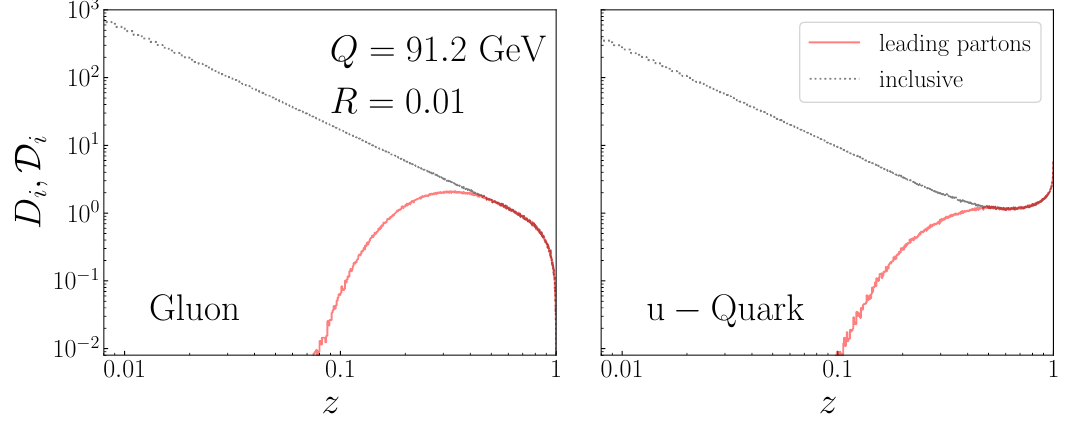
Figure 20 . Fragmentation spectrum of inclusive and leading partons for gluons (left) and u -quarks (right) at the scale Q = 91 . 2